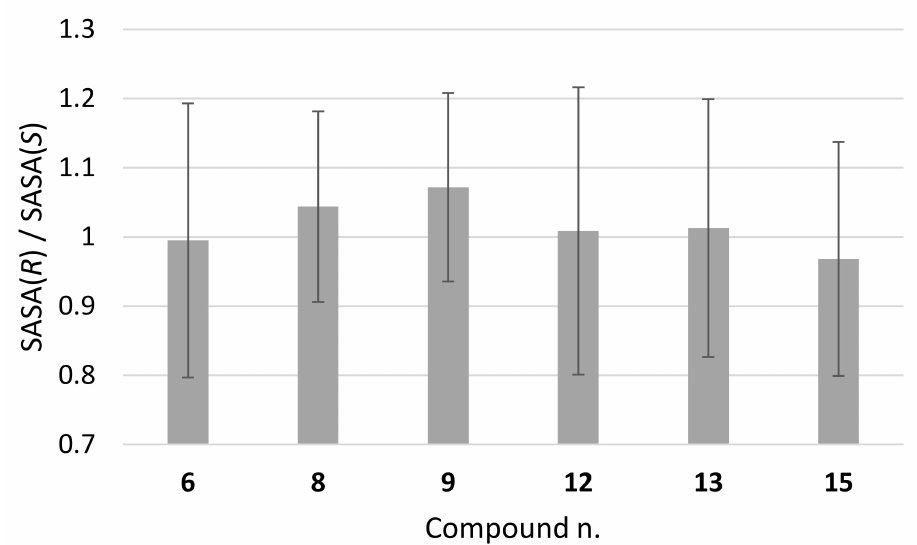
Figure 10. Ratio between average values of solvent accessible surface area (SASA) of ( R ) and ( S ) enantiomers, as calculated from MD